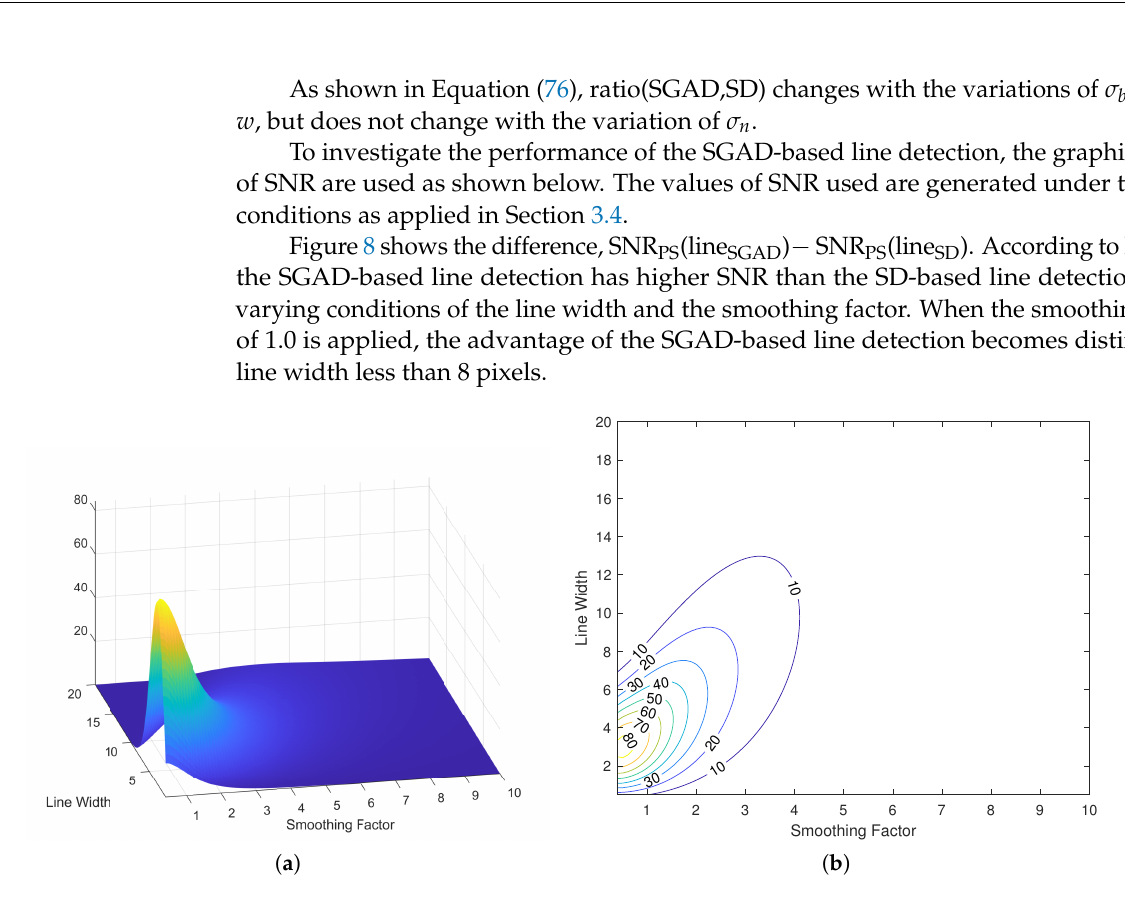
Figure 8. SNR PS (line SGAD ) − SNR PS (line SD ). ( a ) 3-D view and ( b ) contours.